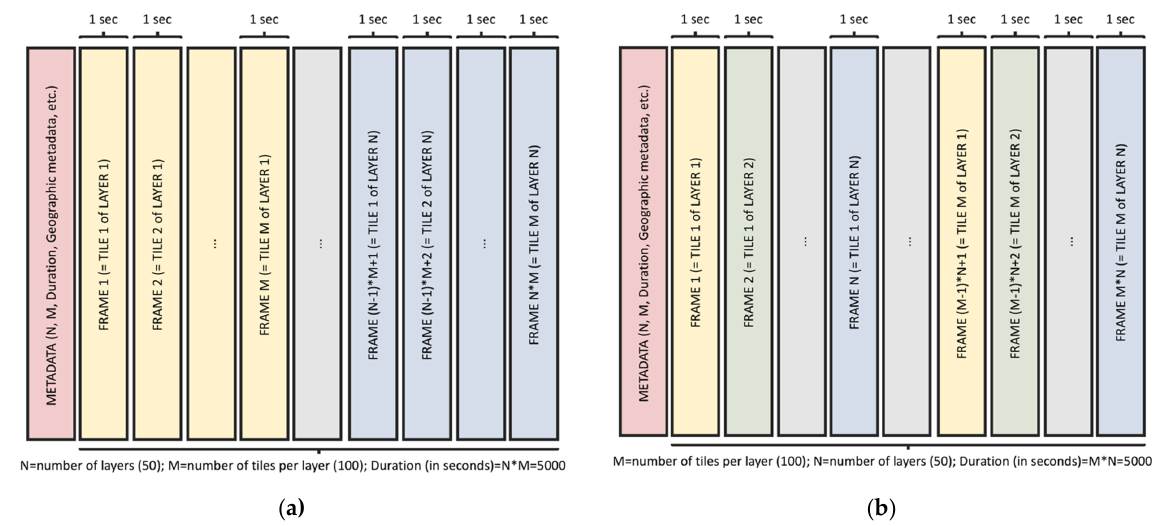
Figure 4. Schematics of two different internal tiling modes in CORE ( a ) layer contiguous (LC) ( b ) tile contiguous (TC).